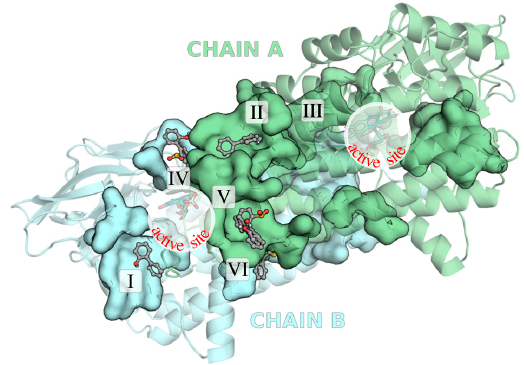
Figure 8. The six binding sites identi fi ed from the docking calculations are shown in surface representation. 2-HBP and HBPS ligands selected from the docking protocol are also shown in ball-and-stick representation. The DszC homodimer is represented in cartoon with the FMN cofactor and DBT substrate represented in sticks.